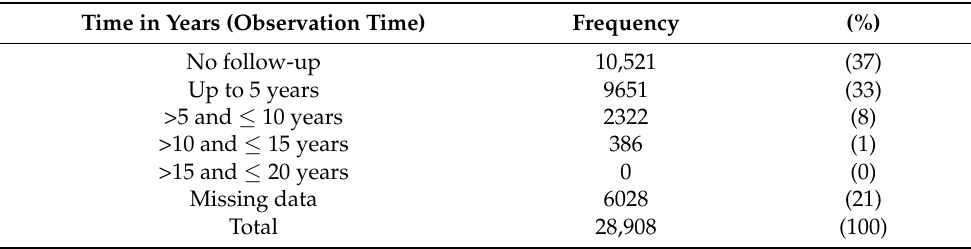
Table 5. Number of patients by the observation time between the first and last visits, from 1 June 2005, to 1 August 2019, while using periodontal clinical notes (clinician-documented diagnoses). Time in Years (Observation